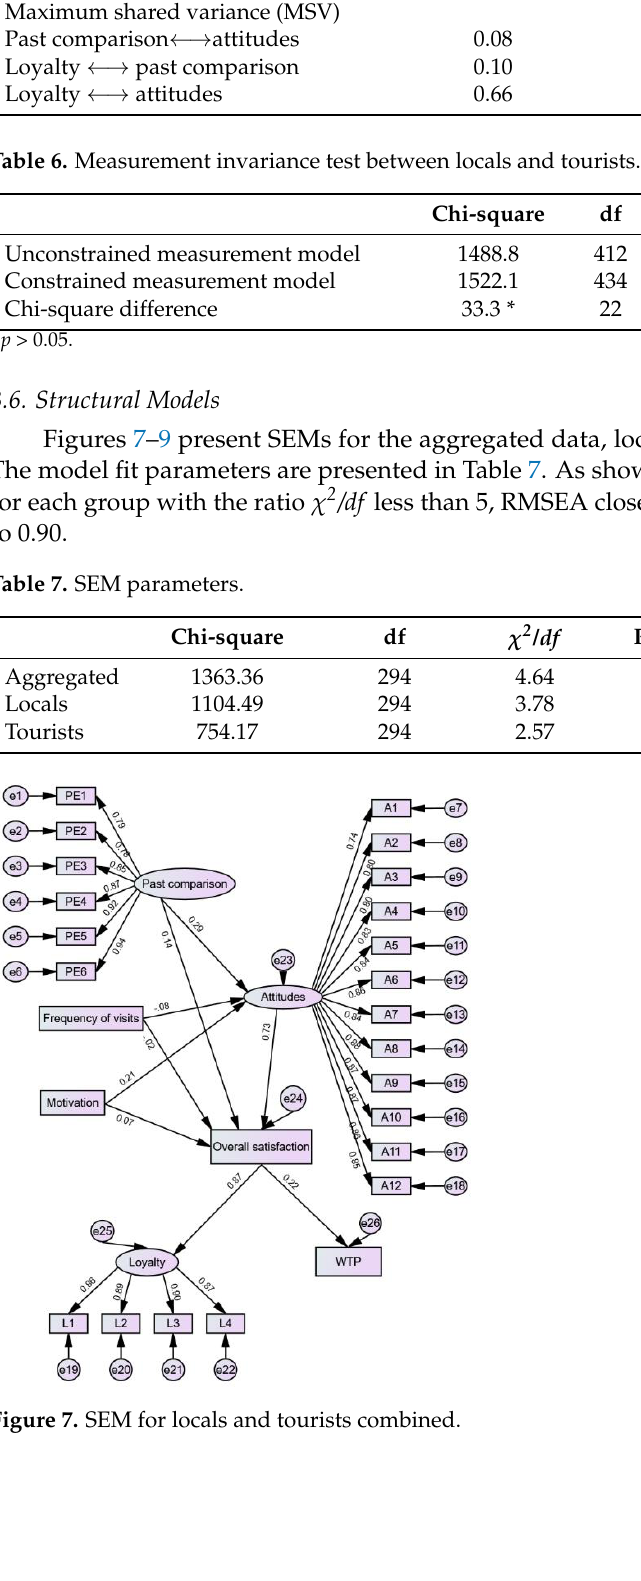
Table 9. Direct effect, indirect effect, and total effect.